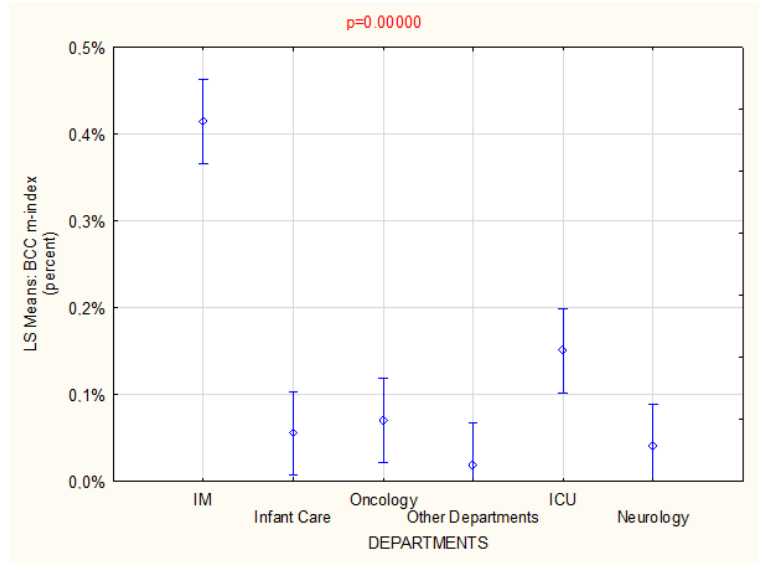
Figure 2. Characteristics of BCC m-index in hospital departments for the period of 2019–2020.